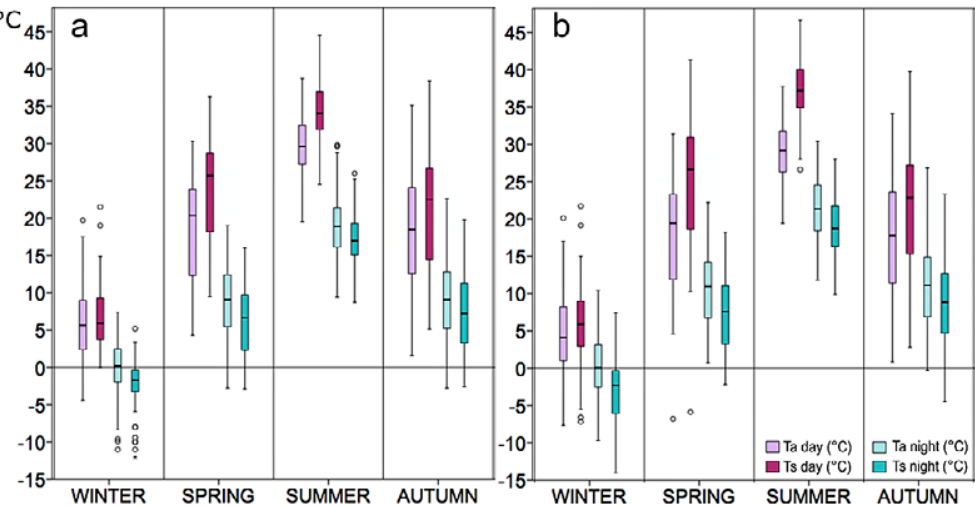
Figure 5. Annual variation of the diurnal and nocturnal thermal reactions of (a) LCZ D and (b) LCZ 2 detected in surface (T ) and air (T ) temperatures, as examples (Szeged, clear days, 01.06.2014 – s a